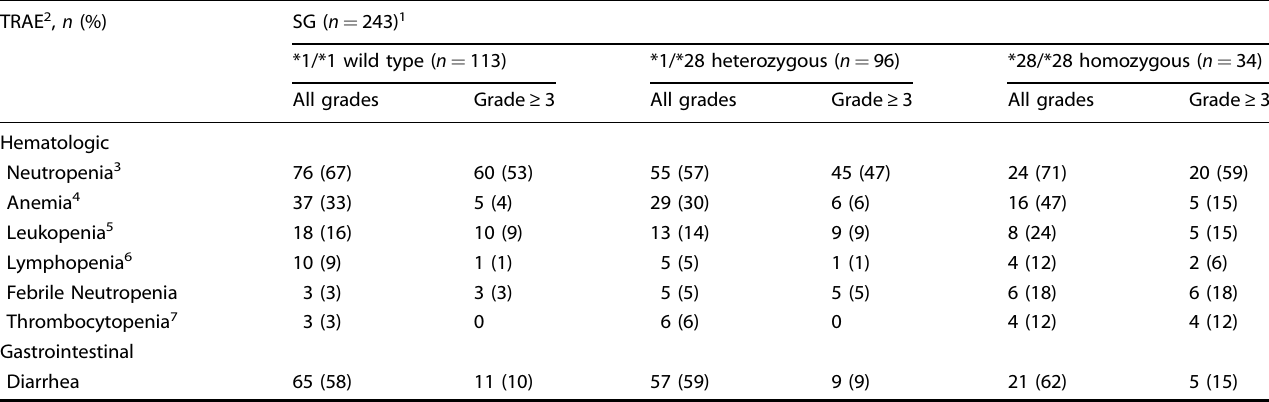
Table 4. Key treatment-related adverse events of all grades in >20% and of grade ≥ 3 in >5% of patients treated with sacituzumab govitecan signi fi cantly impacted by UGT1A1